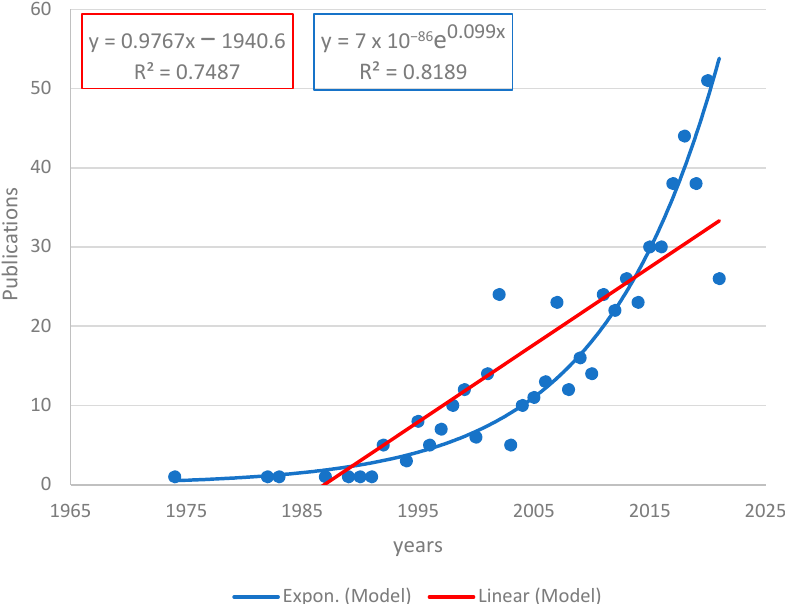
Figure 3. Production of scientific articles related to the hydrocarbon industry based on Scopus and WOS publications.